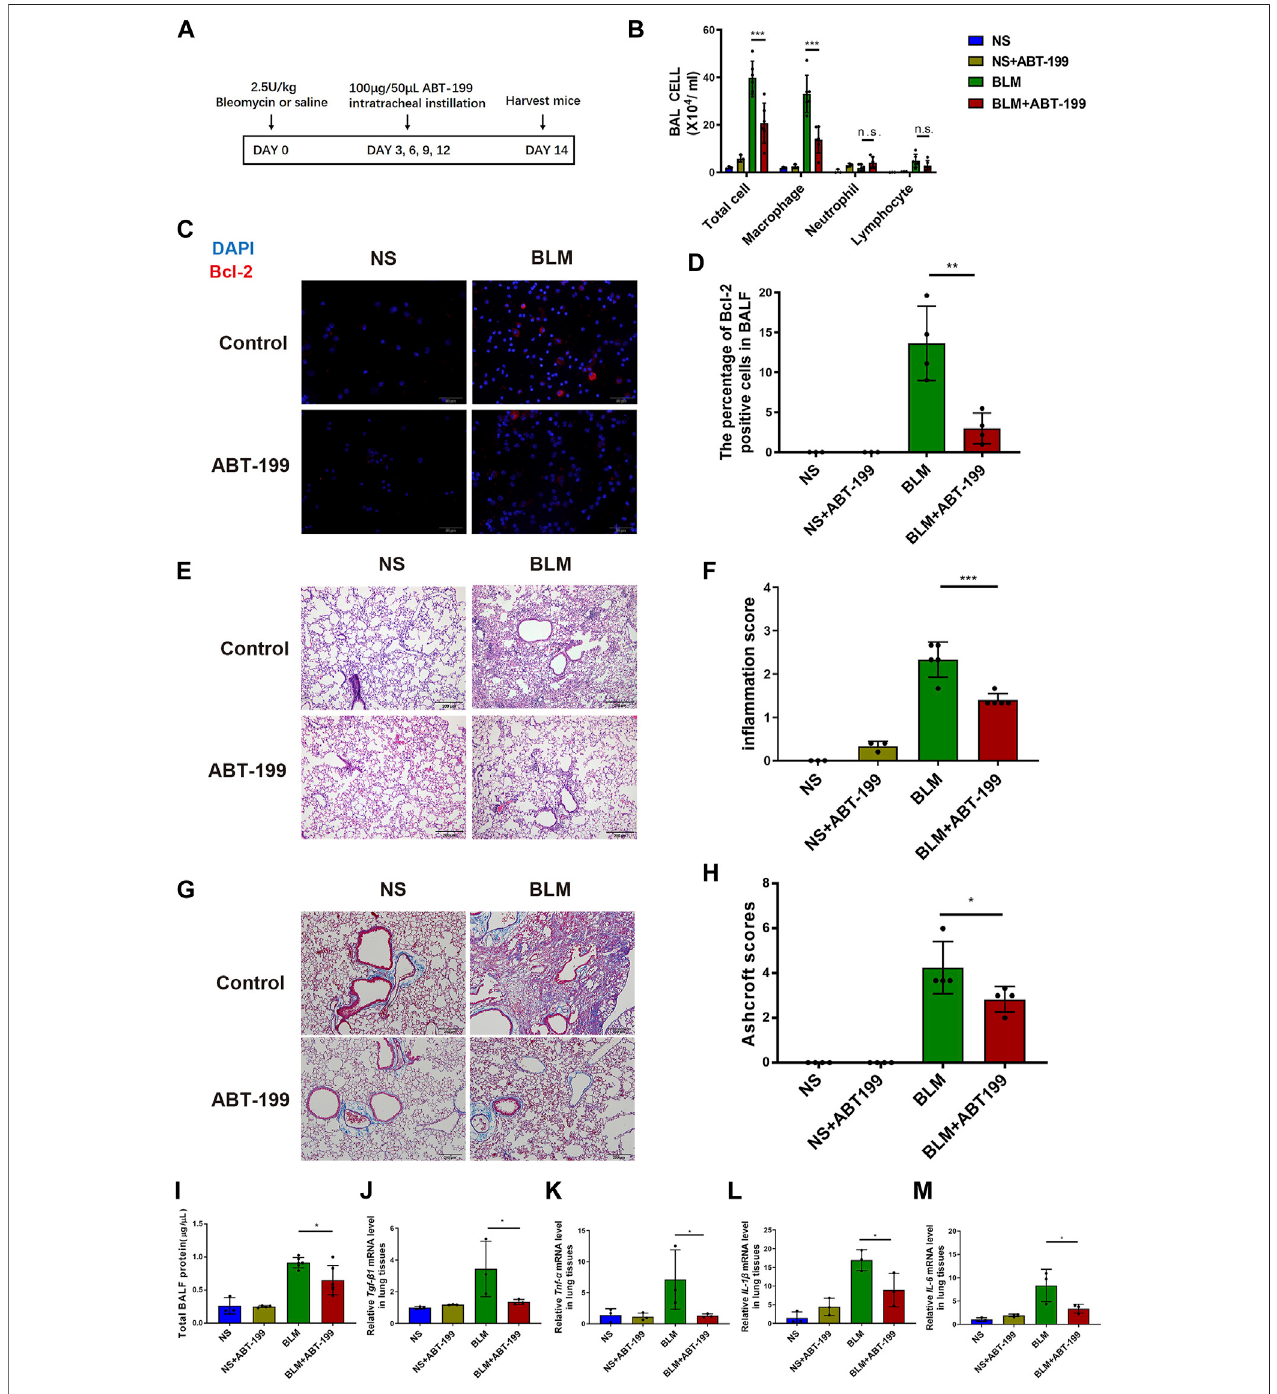
FIGURE 3 | Early ABT-199 treatment attenuated BLM-induced lung in fl ammation at day 14. (A) Treatment scheme. (B) After 14 days, the total number of in fl ammatory cells was quanti fi ed and the number of differential cells was calculated. (C) Intracellular Bcl-2 expression of BAL cells was assessed by immuno fl uorescence assay on day 14. (D) The percentage of Bcl-2 positive macrophages was determined. (E) Representative images of lung sections stained with hematoxylin and eosin (H&E). (F) Degree of parenchymal alveolitis was evaluated using Szapiel score. (G) Representative images of lung sections stained with Masson ’ s trichrome. (H) The area analysis of fi brotic changes according to Ashcroft scale. (I) Total BALF protein on day 14 was measured using BCA Protein Assay. (J – M) The relative levels of Tgf- β 1, Tnf- α , Il-1 β , and Il-6 mRNA transcripts were determined using quantitative PCR. The data are presented as means ± SD of an experiment performed three times. n.s., not signi fi cant, * p < 0.05, ** p < 0.01, *** p < 0.001. n (cid:2) 3 – 6. BLM, bleomycin; BAL, bronchial alveolar lavage; NS, normal saline; TGF- β 1, transforming growth factor- β 1; TNF- α , tumor necrosis factor- α ; IL-1 β , interleukin-1 β ; IL-6, interleukin-6.